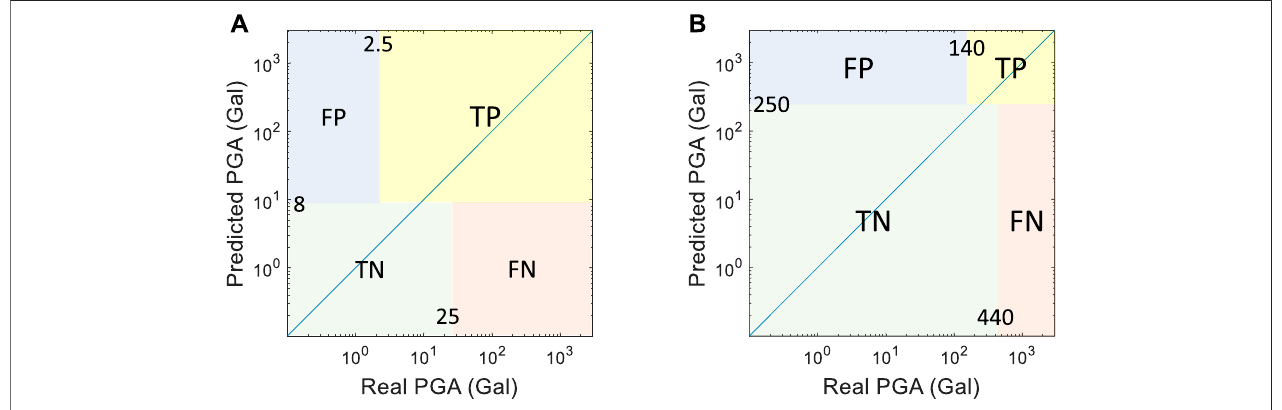
FIGURE 16 | The confusion matrix with tolerance when the threshold is designated as (A) 8 Gal, and (B) 250 Gal.